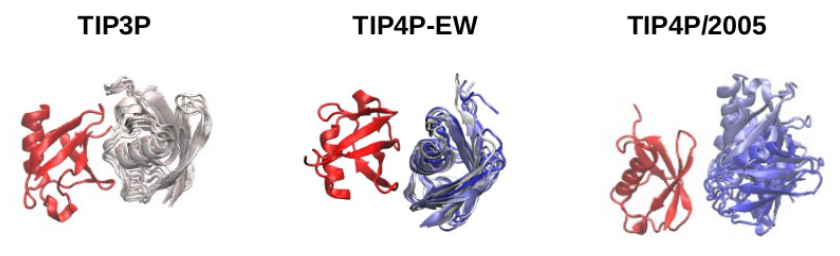
Figure 6. Stability of the bound structures along 100 ns after binding, starting at 100 ns of the trajectory (simulation with TIP3P), 300 ns (TIP4P-EW) and 125 ns (TIP4P/2005). All the snapshots are superimposed to one of the molecules, plotted in red. The snapshots of the other molecule are shown in a time-dependent color scale from white to blue.